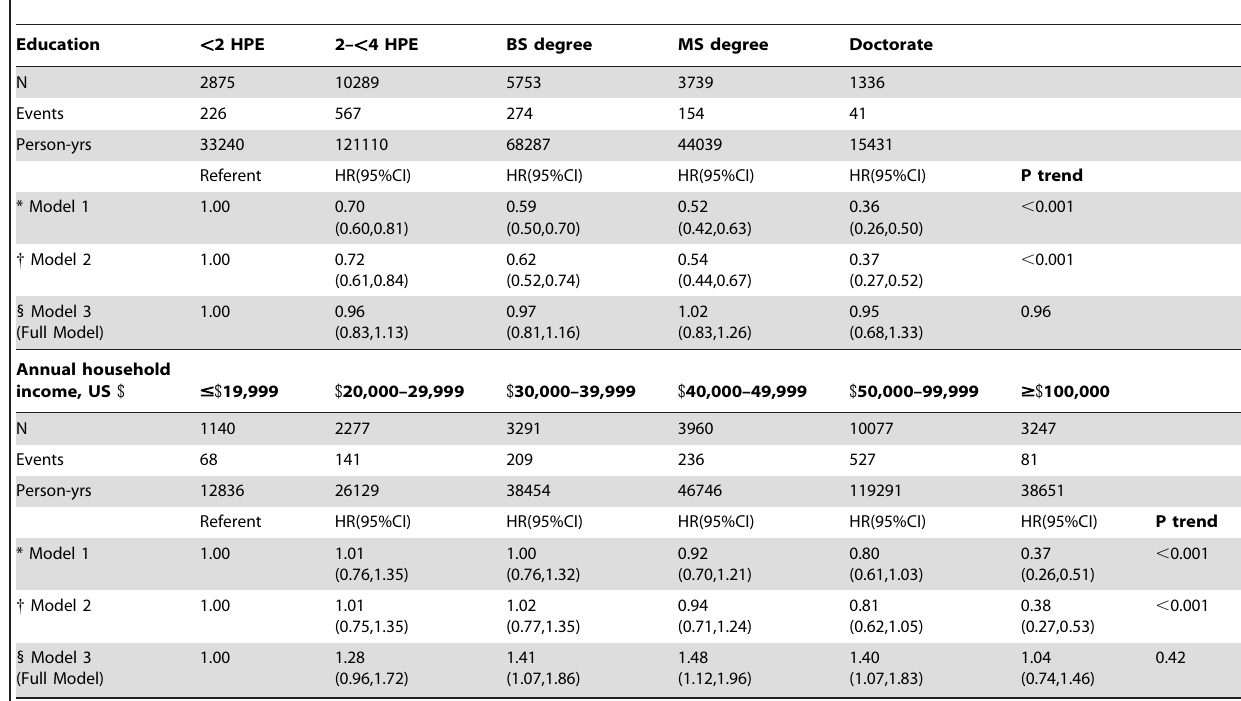
Table 3. Hazard ratios and Associated 95% CI for Incident Diabetes based on Education and